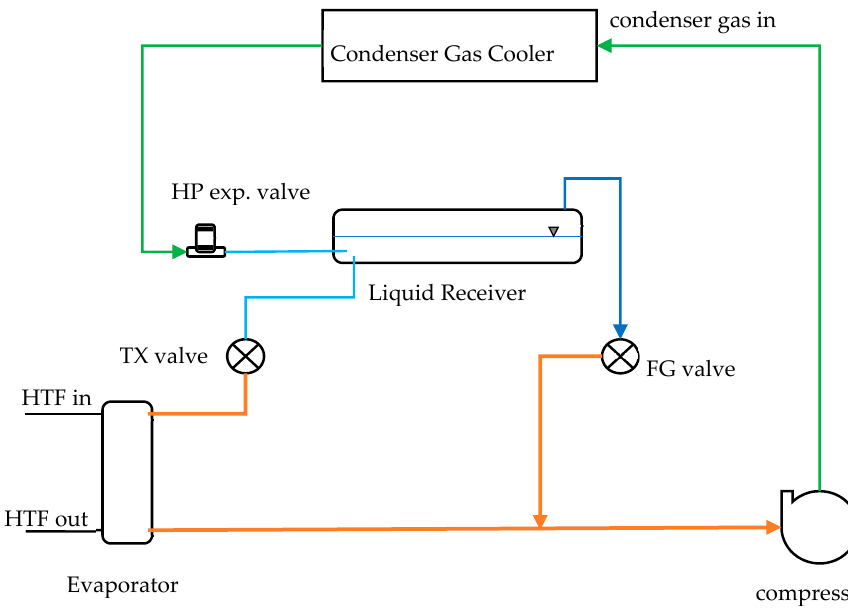
Figure 1. Schematic of the CO 2 system being tested.